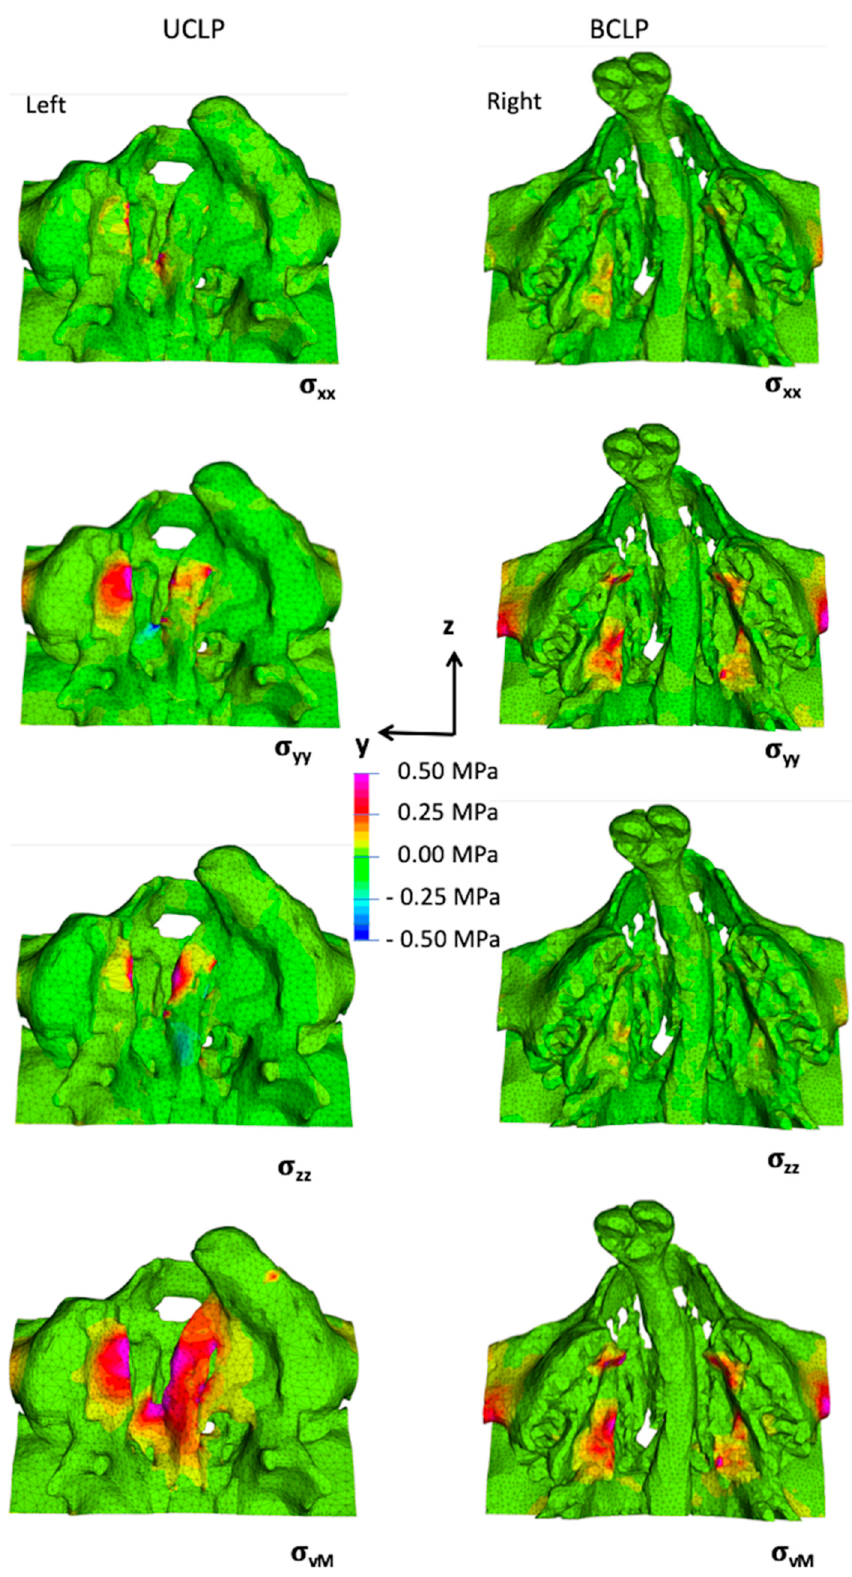
Figure 5. Distributions of the three orthogonal stress components and the von Mises stresses under a 5 N load from palatal view in the UCLP (left column) and BCLP (right column) models. The top second and third rows shows the orthogonal stresses in the X-, Y-, and Z-directions, respectively, and the bottom row shows the von Mises stresses (stress intensity).